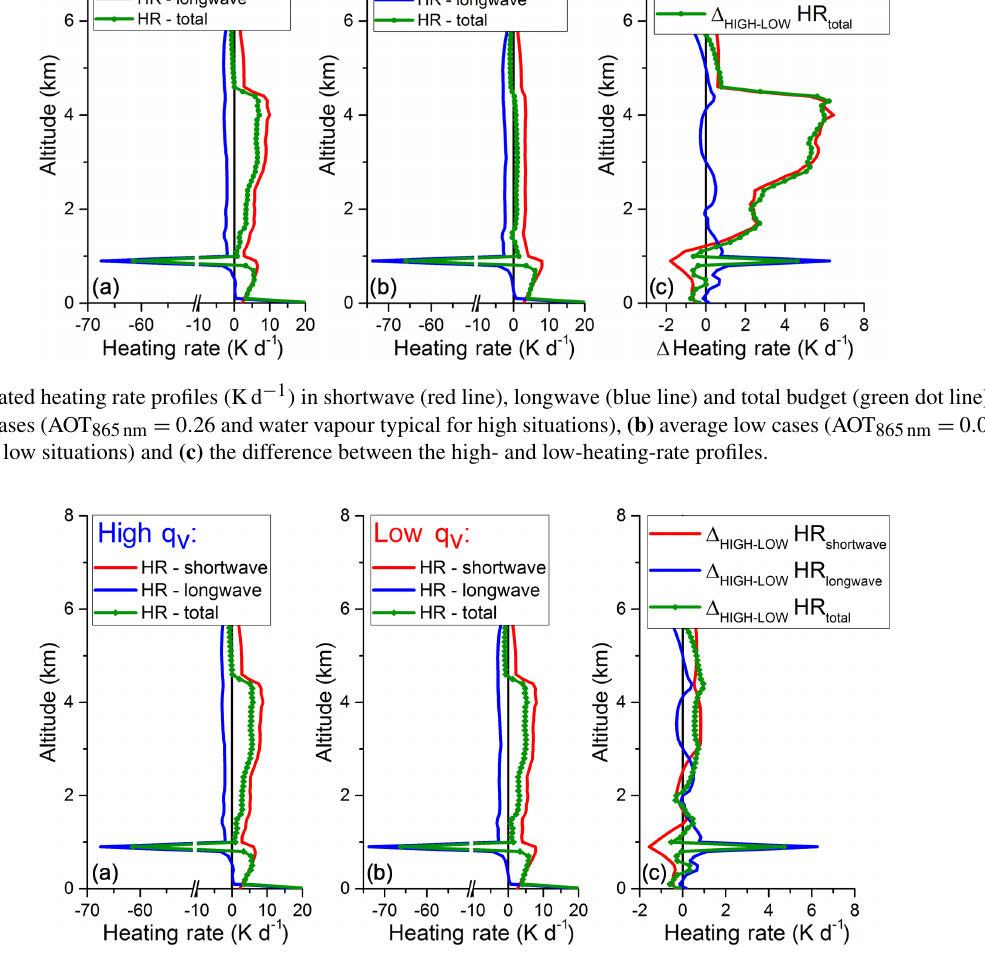
Figure 14. Calculated heating rates profiles (Kd − 1 ) in shortwave (red line), longwave (blue line) and total budget (green dot line) at 12h, for an average AOT 865nm over the region of 0.21 and (a) water vapour typical of the high situation and (b) water vapour typical of the low situations. The last panel (c) presents the difference between the high- and low-heating-rate